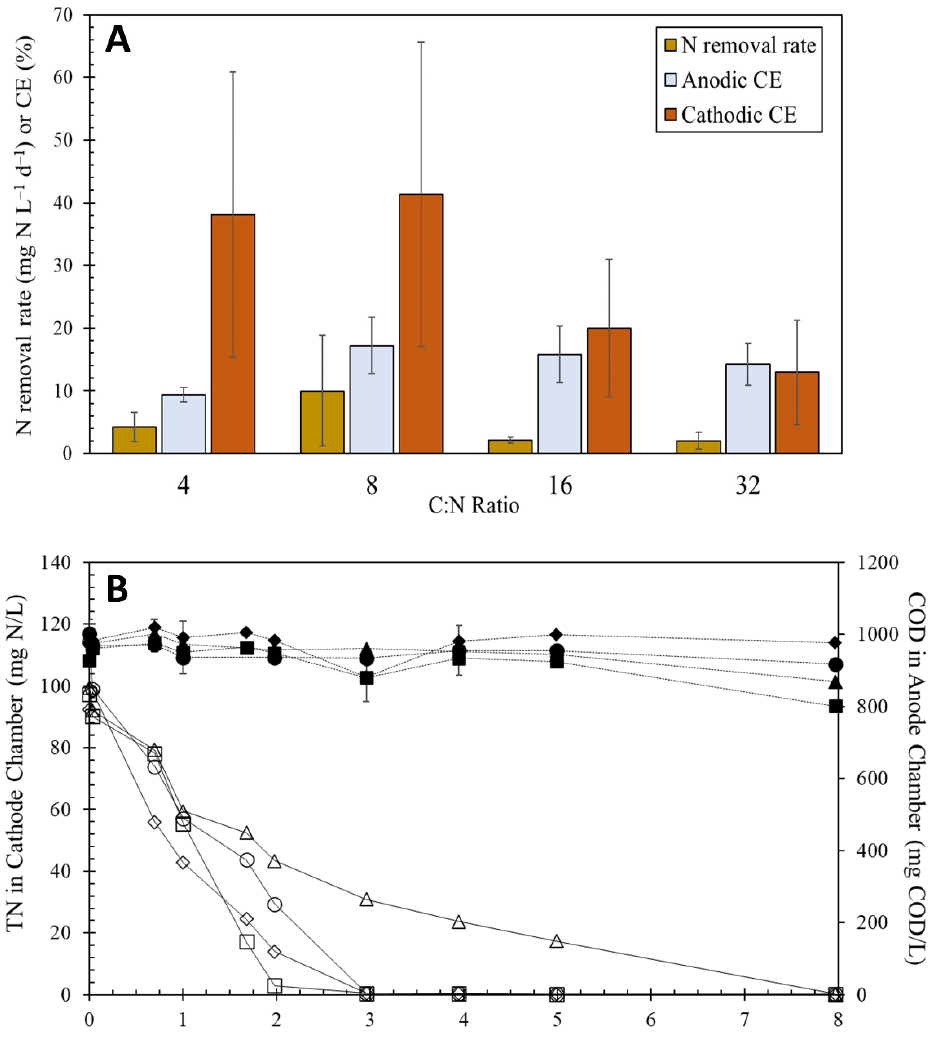
Figure 1. ( A ) Average nitrogen removal rates, anodic CE, and cathodic CE among MFC replicates. n = 4, 3, 3, and 4 for C:N ratios of 4, 8, 16, and 32, respectively; ( B ) concentrations of anode carbon (unfilled) and total cathode nitrogen (filled) for all replicates during 4 C:N. each shape in ( B ) represents a different replicate.